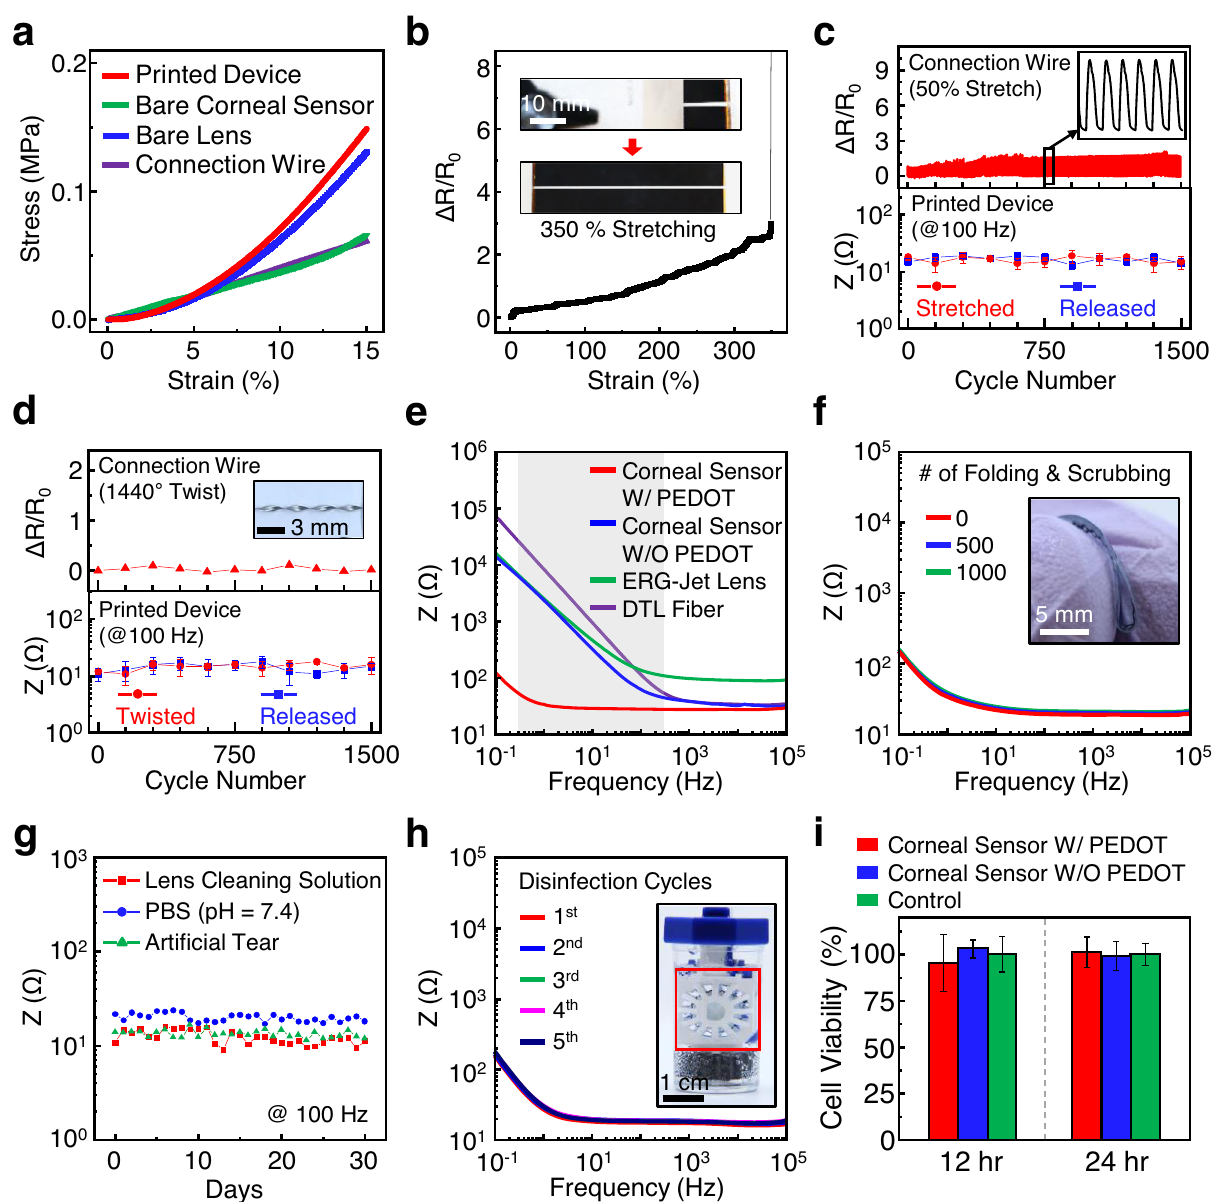
Fig. 2 Characterizations of the corneal sensor. a Average stress – strain curves for the corneal sensor, the bare corneal sensor (without the SCL), the bare SCL, and the connection wire. b Relative change in resistance ( Δ R / R 0 ) of the connection wire under stretching up to 350%. The inset images show the stretched wire. c Δ R /R 0 of the connection wire under 1500 cycles of stretching at 50% (top panel) and the consequent change in the electrochemical impedance of the corneal sensor at every 150 cycles (bottom panel). d Δ R / R 0 of the connection wire under 1500 cycles of twisting up to 1440° (top panel) and the consequent change in the electrochemical impedance of the corneal sensor at every 150 cycles (bottom panel). e Electrochemical impedance of the corneal sensor as a function of frequency by comparisons with current clinical standards. f Electrochemical impedance of the corneal sensor under 1000 cycles of folding and scrubbing. g Electrochemical impedance of the corneal sensor immersing in several aqueous media for 30 days. h Electrochemical impedance of the corneal sensor for fi ve cycles of disinfection processes. The inset image shows a commercial cleansing kit fi lled with a 3% H 2 O 2 formula. i Cell viability assay of human corneal epithelial cells (HCEpiCs) seeded on the corneal sensor with and without a PEDOT layer by comparison with bare control cells ( n =